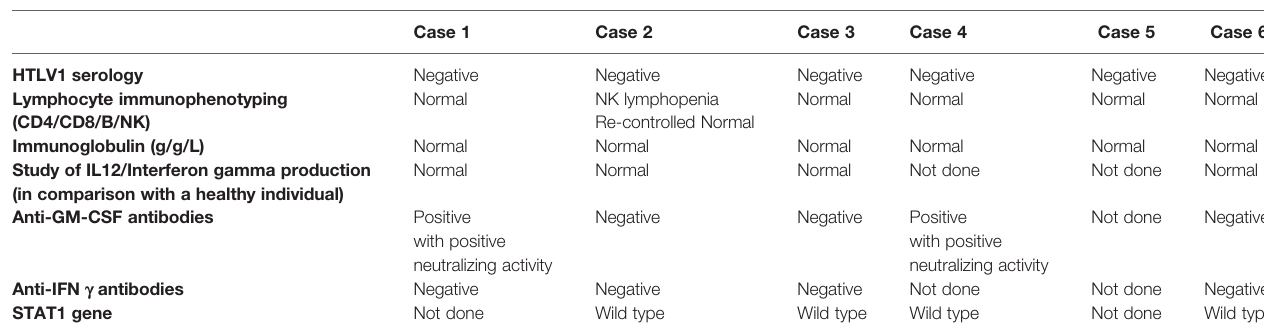
TABLE 2 | Immune exploration of the Cryptococcosis cases.